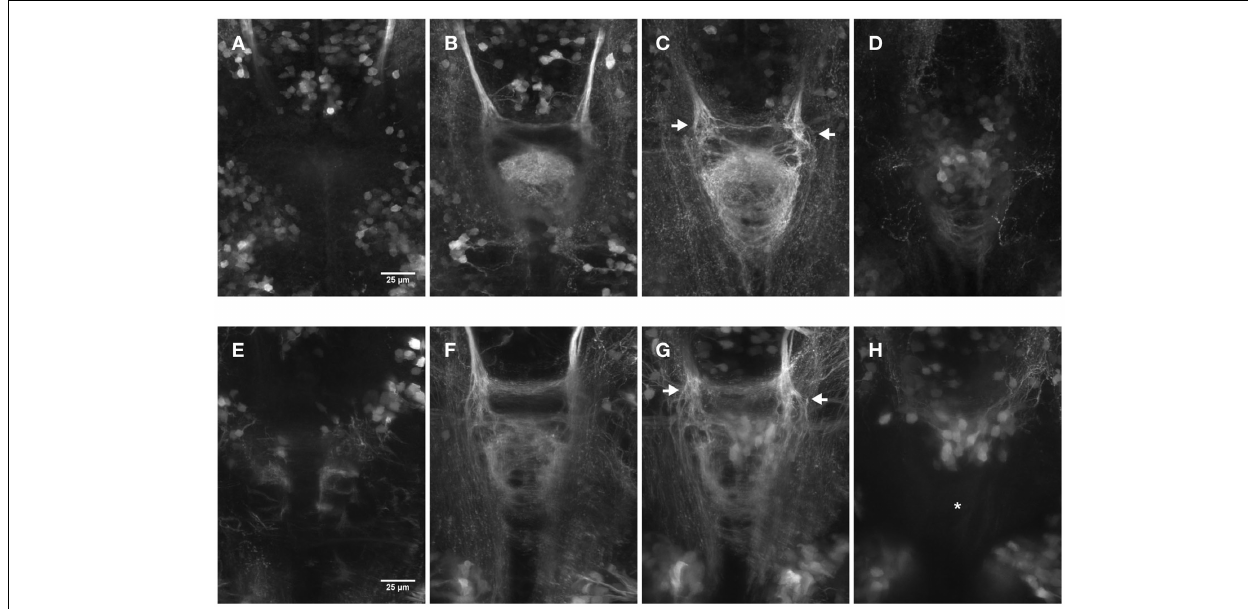
compensate for increasing depth.The display range is kept constant within the series and the gamma was corrected to 0.5 using FiJi for display purpose. (C–G) The arrows highlight the axons entering the IPN area more dorsal on the left and more ventral on the right side. Asterisk in (H) : less structures can be observed compared to (D) due to the fact that (H) shows a deeper range past the IPN that view (D) does (9–34 μ m versus 2–17 μ m after the “end” of the